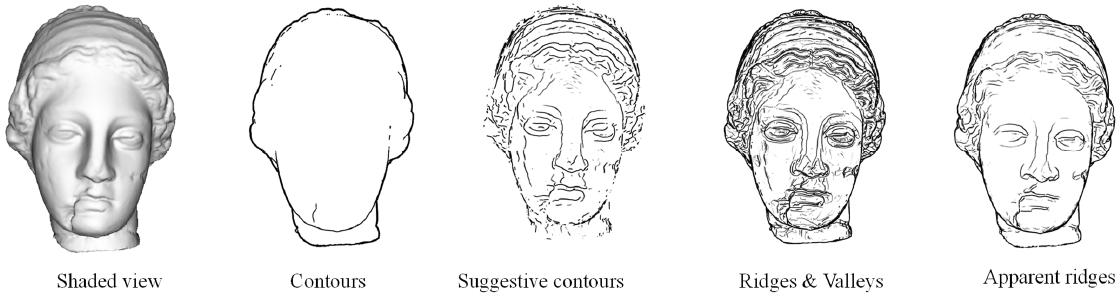
Figure 4. Comparison of the various feature lines [7].